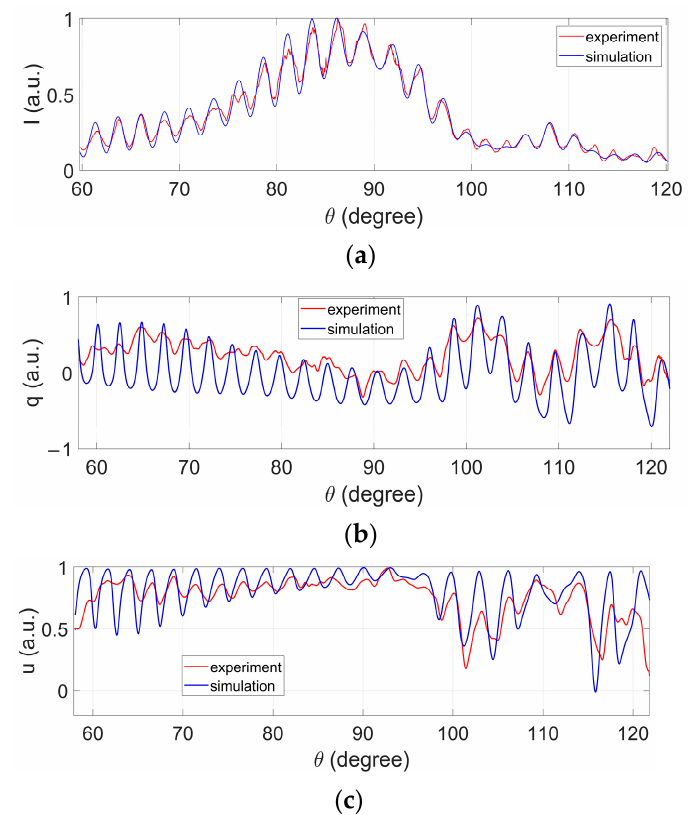
Figure 4. Experiment and simulated results of scattered intensity I ( a ), polarization parameters q ( b ), and u ( c ) for SiO 2 .